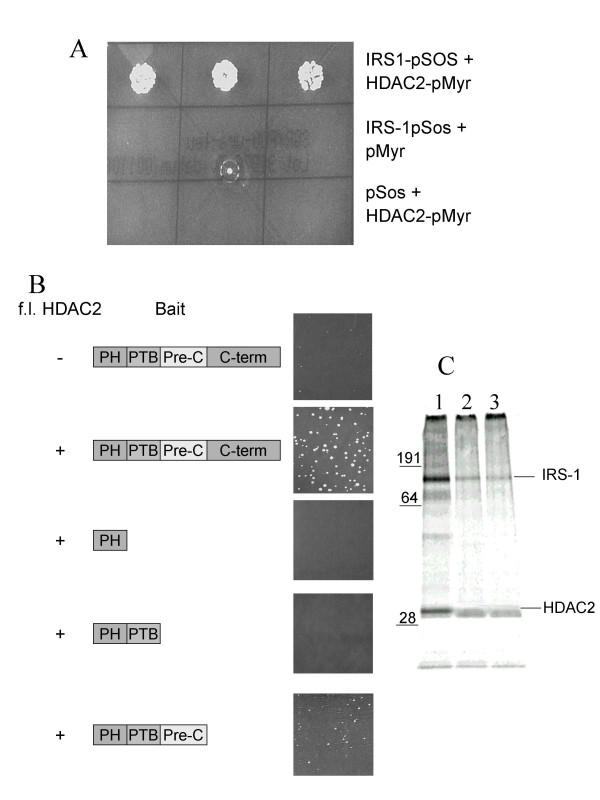
Analysis of the interaction between IRS-1 and HDAC2 in vitro. A: A human foetal brain plasmid cDNA library contained in the p-myr vector was transformed into yeast cdc25 h cells containing full length IRS-1 in the pSos vector. Cell growth at the non-permissive temperature (37°C) on galactose medium (GAL 1 promoter in the library vector) was observed only in the presence of both IRS-1 and HDAC2 from the library from two independent transformants, which both encoded human HDAC2. B: Full length HDAC2 and different sub-cloned domains of IRS- 1 were used in the Matchmaker-3 yeast two-hybrid system to map the interaction between HDAC2 and IRS-1. Growth on medium lacking two nutritional markers was analysed to confirm interactions between predator and prey. C: Recombinant human IRS-1 and HDAC2 were transcribed and translated in vitro individually using a rabbit reticulocyte lysate as described in the Methods section. Proteins were then mixed and IRS-1 was immunoprecipitated from the solution (lane 1). As controls for the immunoprecipitation, the IRS-1 antibody was denatured by boiling prior to immunoprecipitation (lane 2) or all antibodies were omitted and beads alone were used (lane 3). Proteins were resolved by SDS-PAGE, the gel was dried and immunoprecipitated proteins were analysed by phosphorimagery. Protein bands matched IRS-1 (approx 160 kD) and truncated HDAC2 (approx. 35 kD).